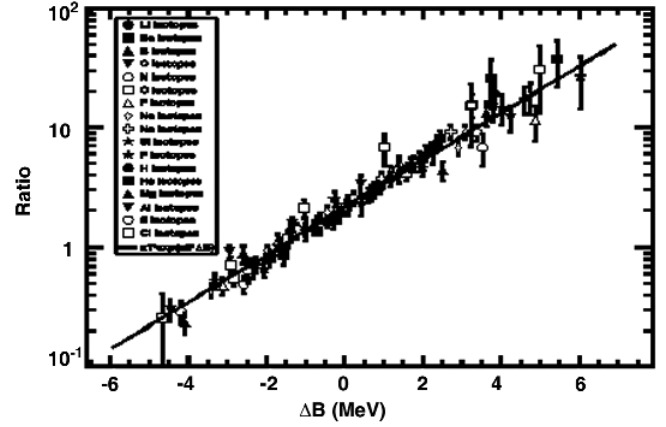
Figure 4: Scaling of experimental yield ratios with binding energy differences for 86 , 78 Kr + 64 , 58 Ni reactions at E/A=35 MeV. Data imported from